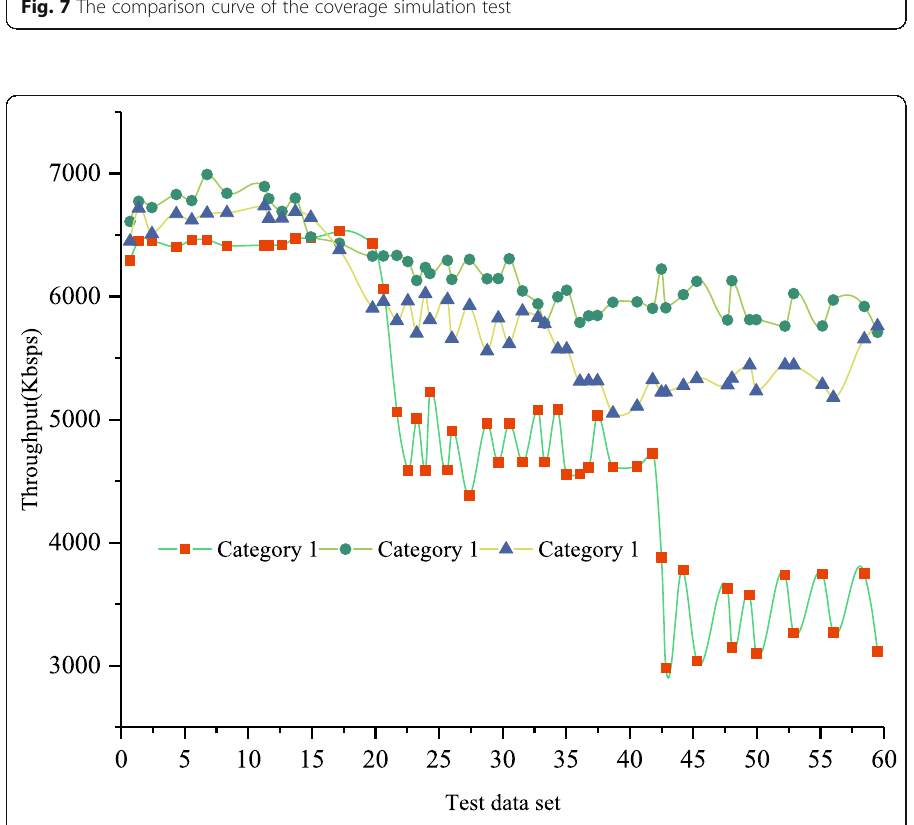
Fig. 8 The comparison curve of accuracy simulation